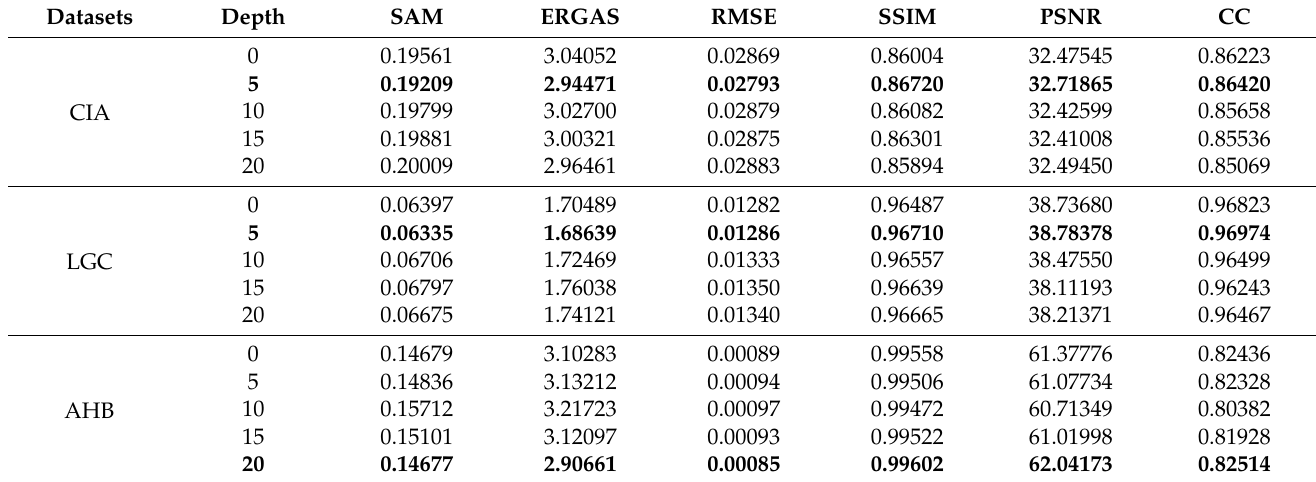
Table 5. Average evaluation values of Transformer encoders of different depths on the three datasets. Datasets